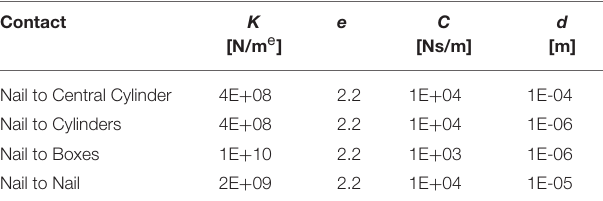
TABLE 2 | Contact parameters for the conceptual ring geometry. Contact